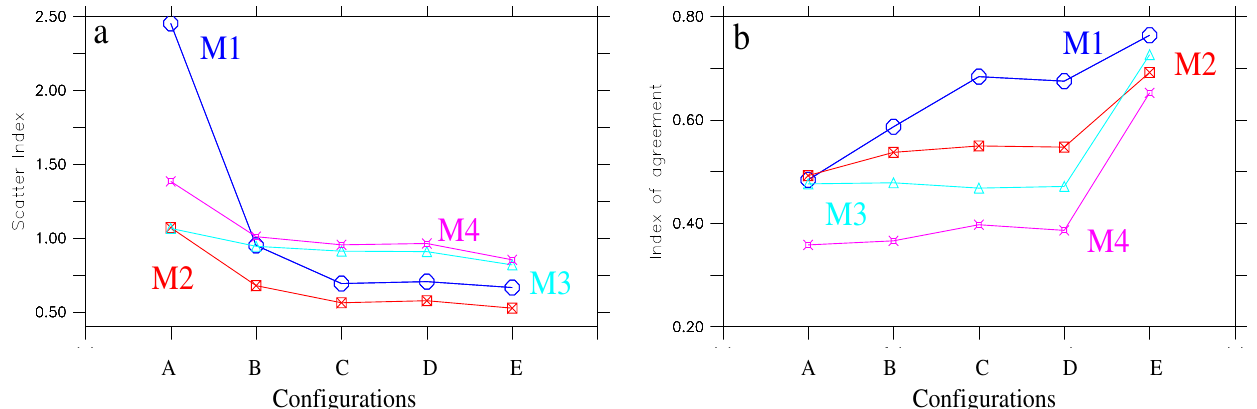
Figure 6. ( a ) Scatter index and ( b ) index of agreement in predictions of near-surface SSC at Points M1, M2, M3 and M4 in Configurations